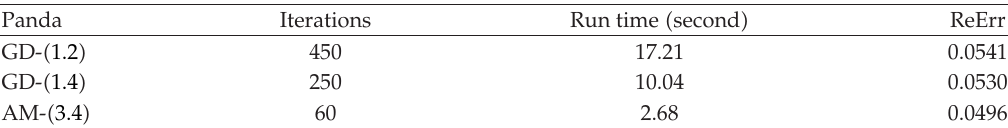
Table 3: Number of iterations, computational time, and ReErr of the three methods for the results in Figure 6.